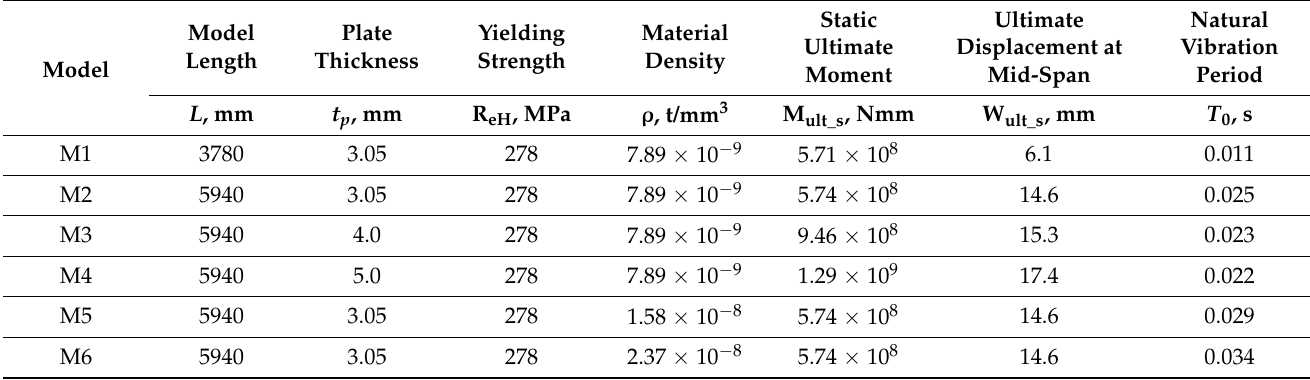
Table 2. Box girder models for dynamic ultimate strength